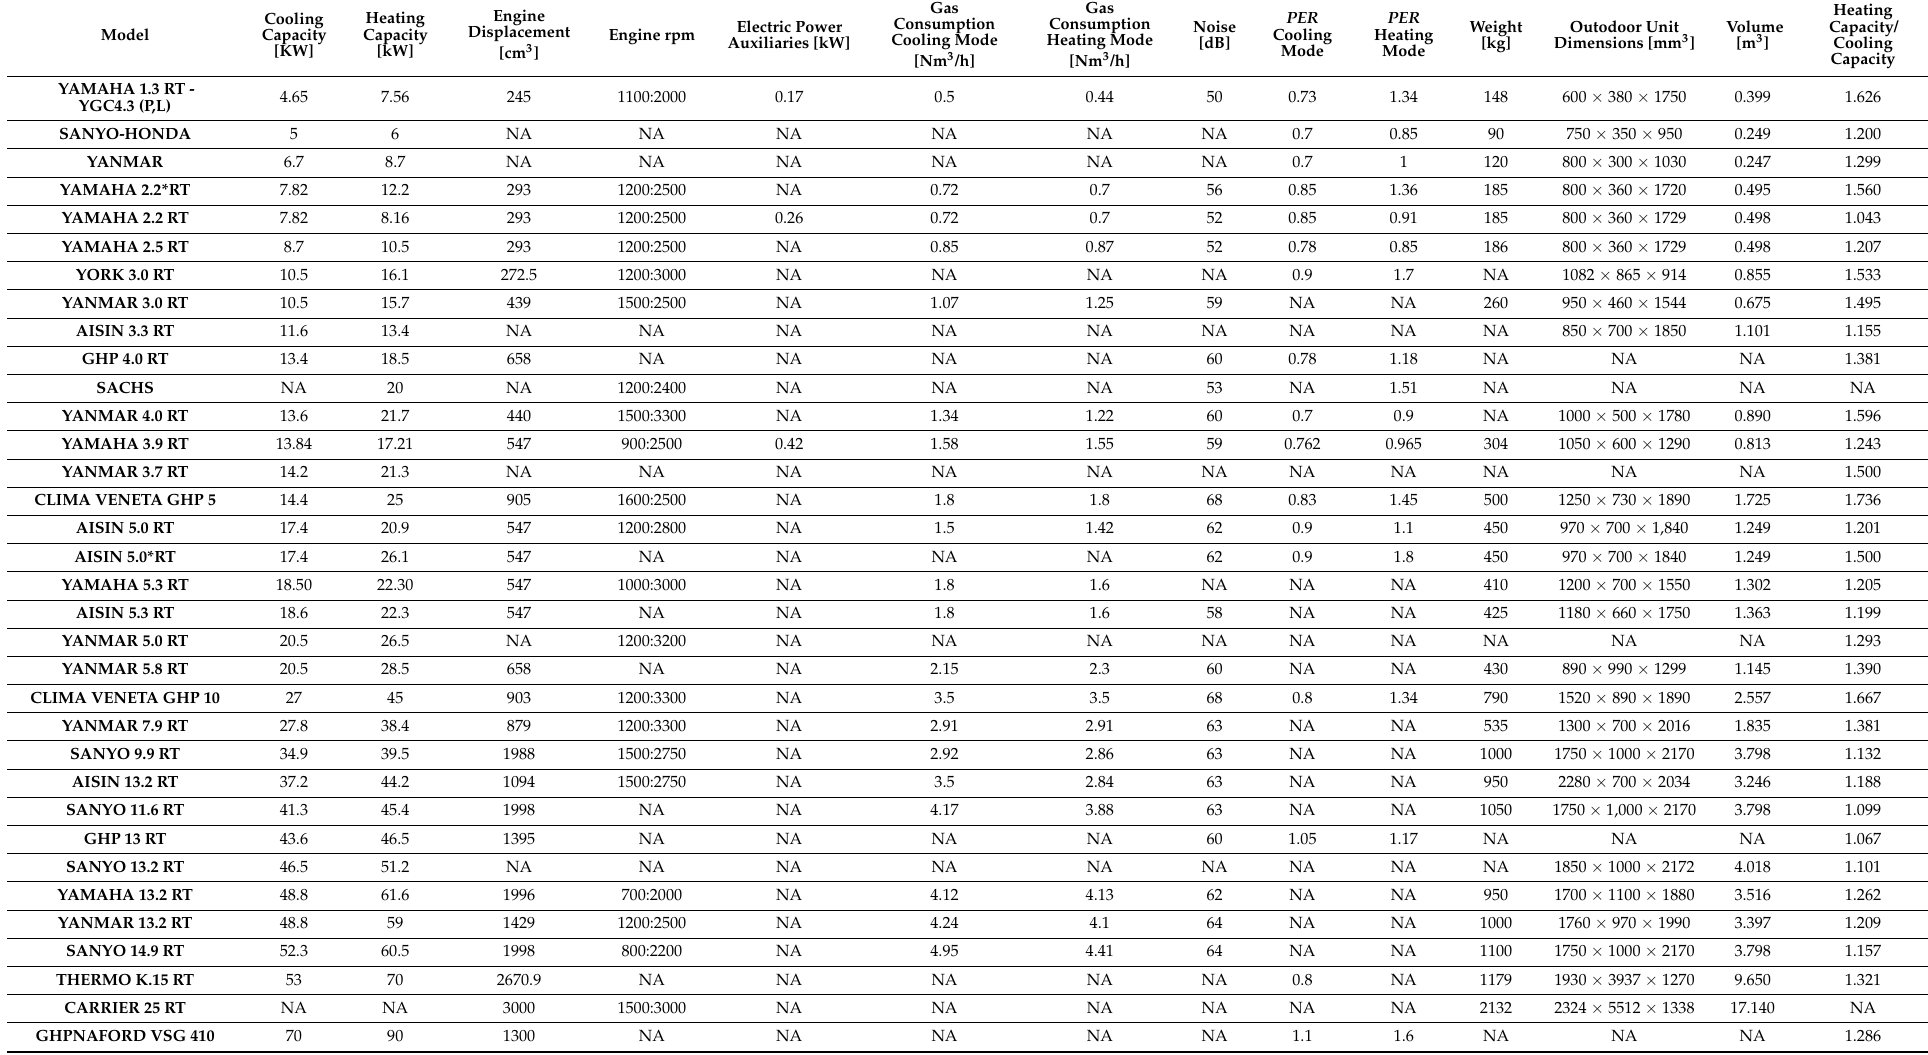
Table A1. GEHPs available on the market during the past